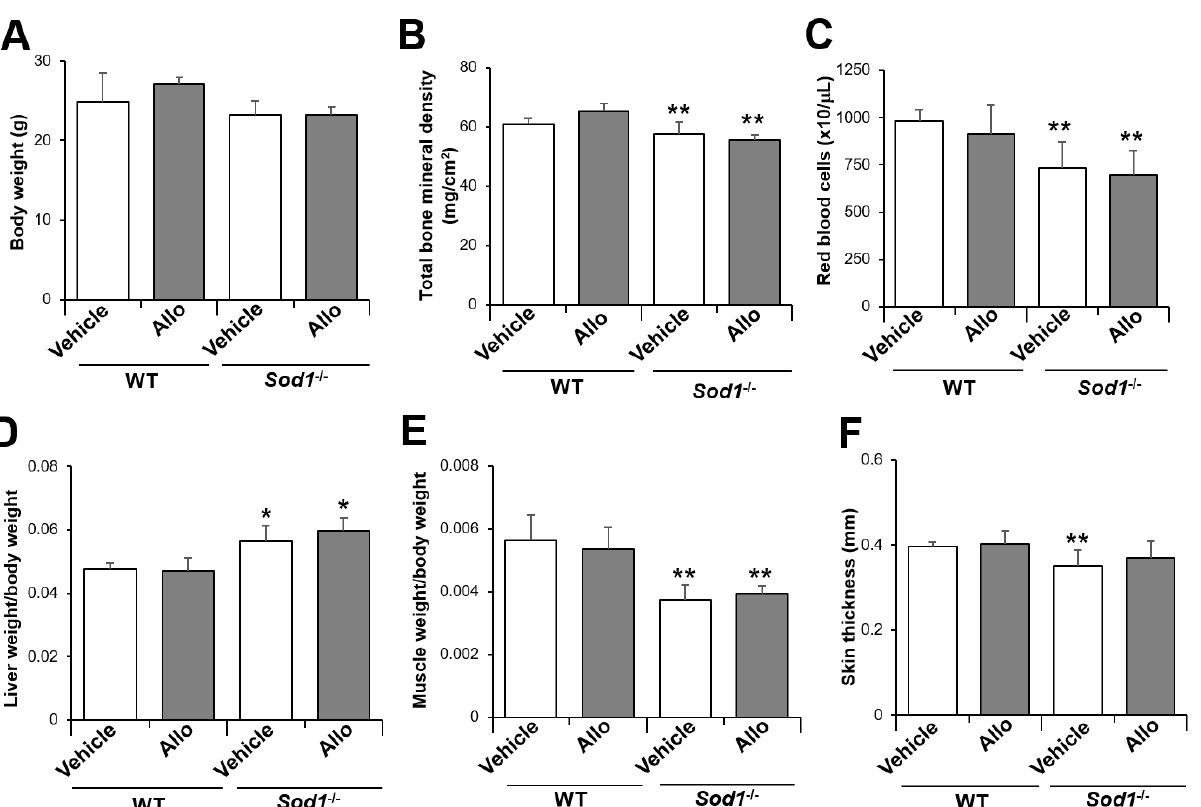
Figure 3. Administration of allopurinol to adult Sod1 − / − female mice. The body weight ( A ), total bone mineral density ( B ), red blood cell count ( C ), ratio of liver weight/body weight ( D ), ratio of muscle weight/body weight ( E ), and skin thickness ( F ) of WT and Sod1 − / − female mice (7 months of age, n = 4–5) administered allopurinol for 8 weeks. * p < 0.05, ** p < 0.01. Data are shown as the mean ± SD.